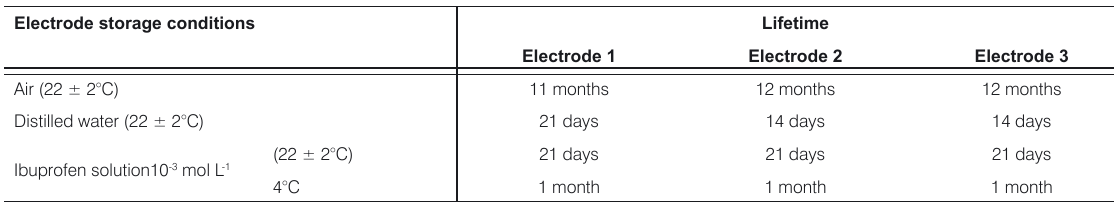
Table 3. The effect of storage conditions of ibuprofen electrodes on their